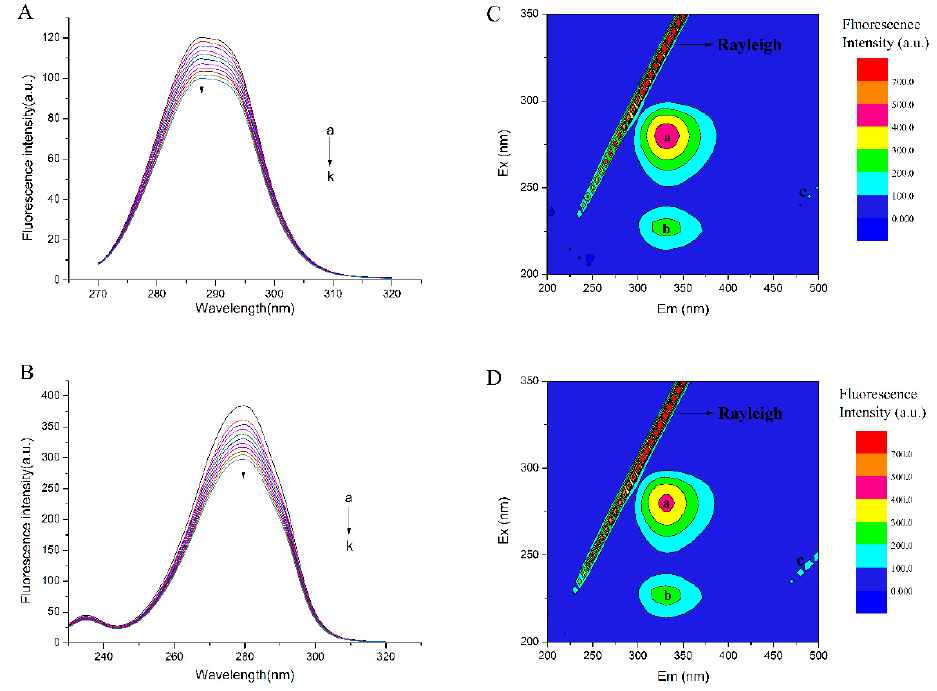
Figure 4. Synchronous fluorescence spectra of bLf with varying concentration of TCH ( A : Δ λ = 15 nm, B : Δ λ = 60 nm). Fluorescence EEM landscapes of bLf ( C ) and the TCH-bLf systems ( D ).